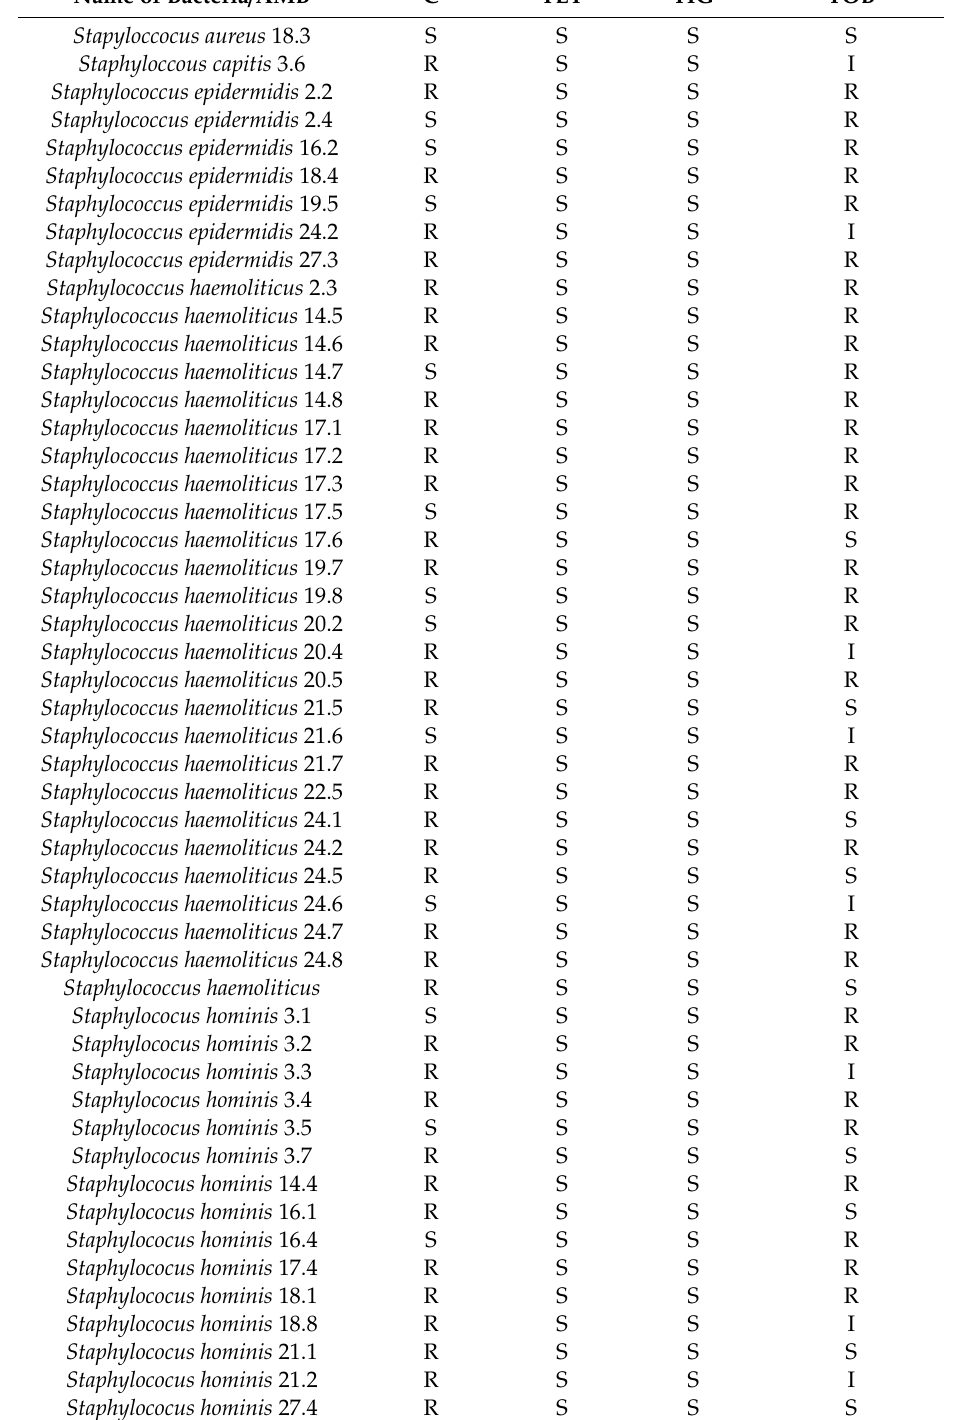
Table 2. Antimicrobial resistance of Staphylococcus